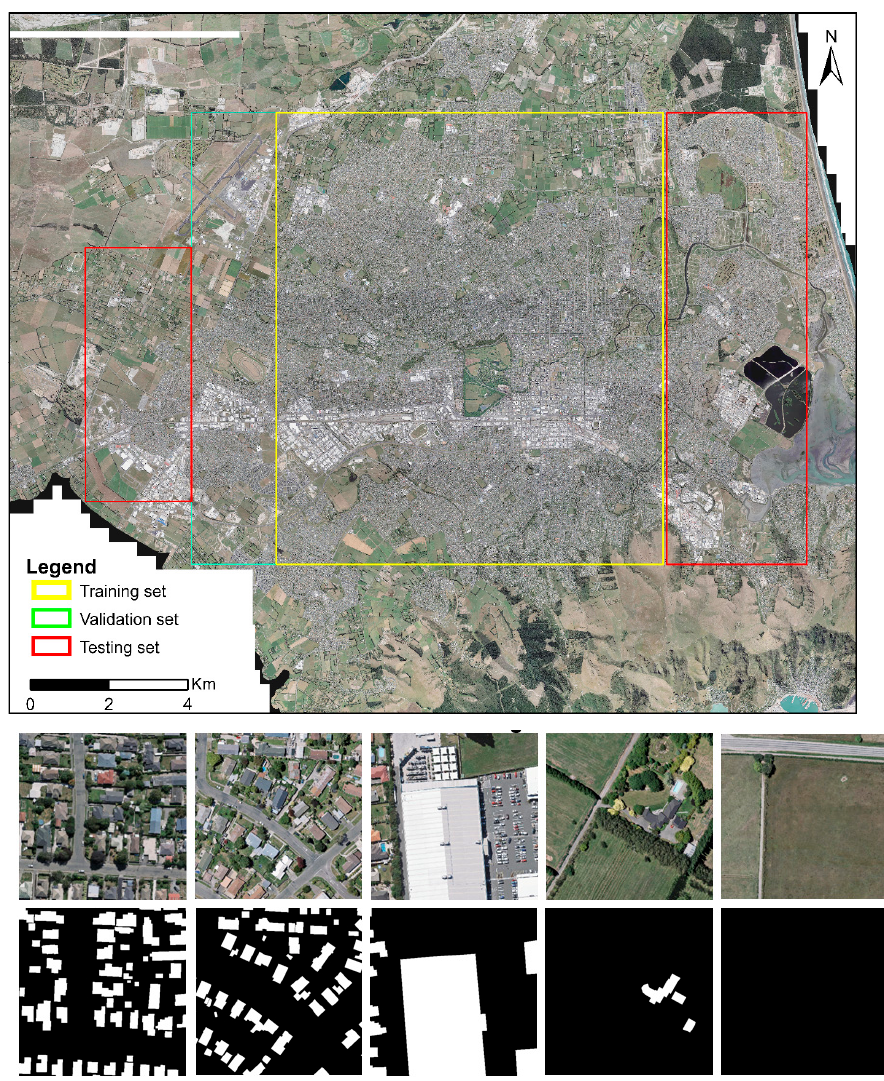
Figure 4. The spatial distribution of the training set, validation set, and testing set in the WHU aerial building dataset and the illustration of image tiles with different building landscapes and truth la- bels.